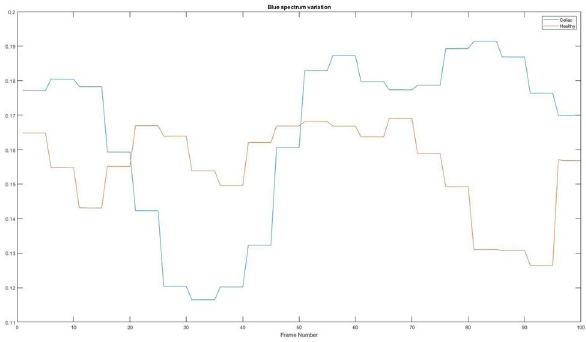
Figure 16. Blue spectrum variation. Red = Healthy and Blue = Celiac.